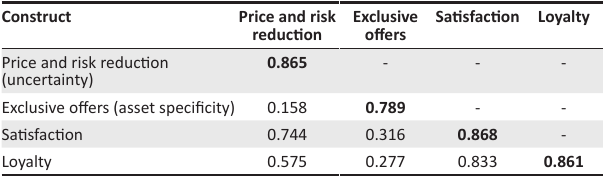
TABLE 4: Correlation matrix indicating discriminant validity.